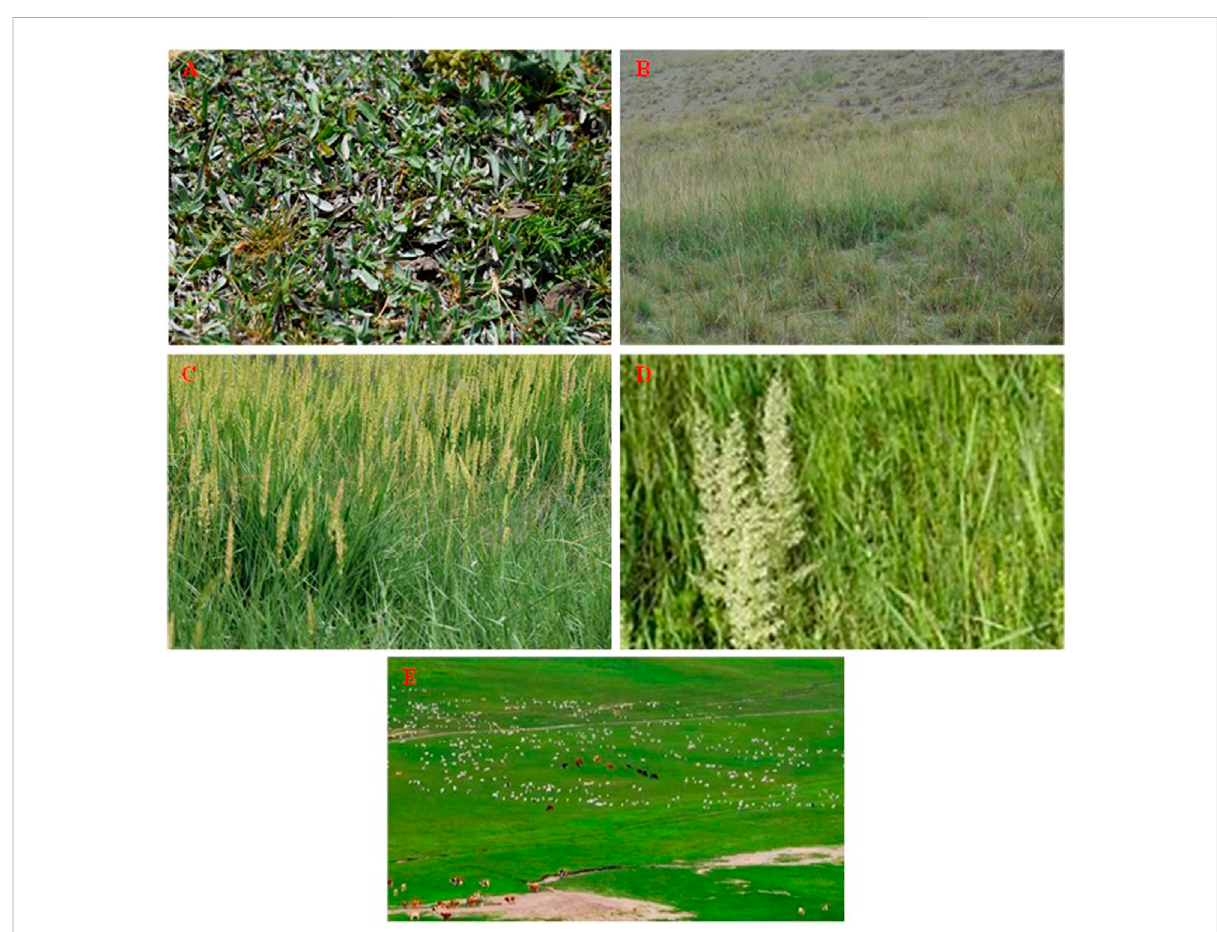
FIGURE 2 Picture of selected alpine grass species patches; (A) Leontopodium nanum (B) Stipa aliena, (C) Leymus secalinus, (D) Koeleria pers, and (E) the grassland showing a bare